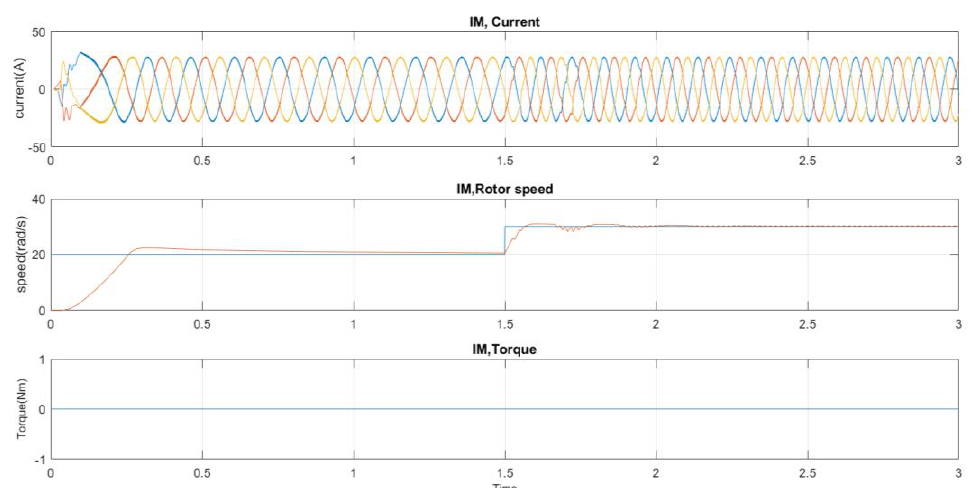
Figure 5. Effective reaction of autonomous wind/storage production component providing IM when the suggested control for step changes in velocity of IM.